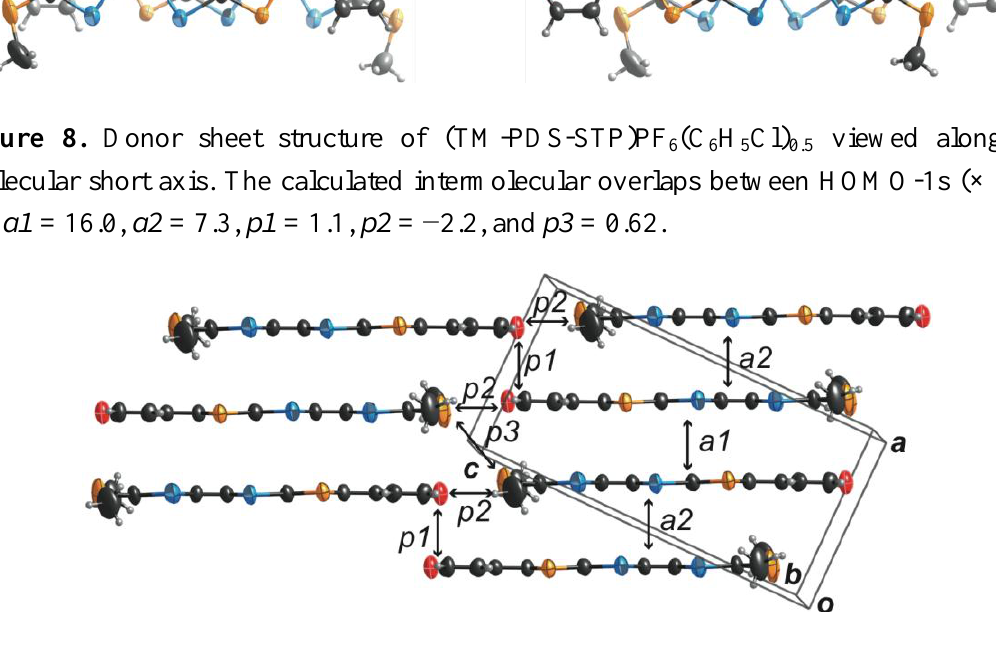
(C H Cl) viewed along the 6 6 5 0.5